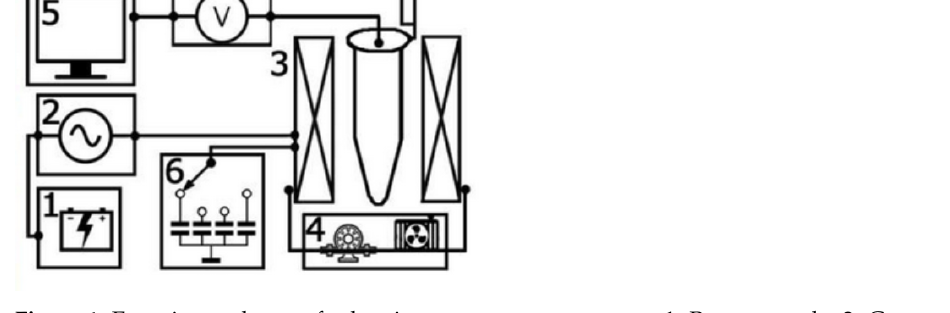
Figure 1. Experimental setup for heating power measurements: 1. Power supply; 2. Generator; 3. Solenoid; 4. Water cooling system; 5. System of collecting and monitoring data. 6. Re-configurable system of